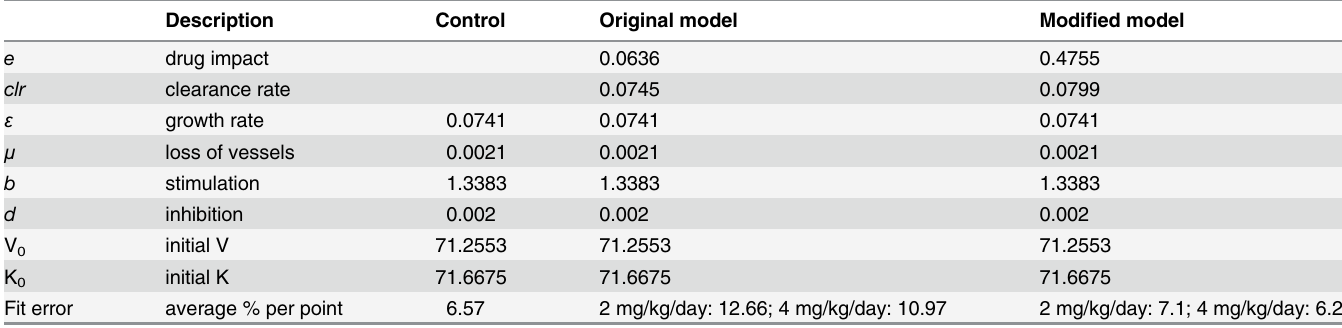
Table 1. Estimated tumor growth